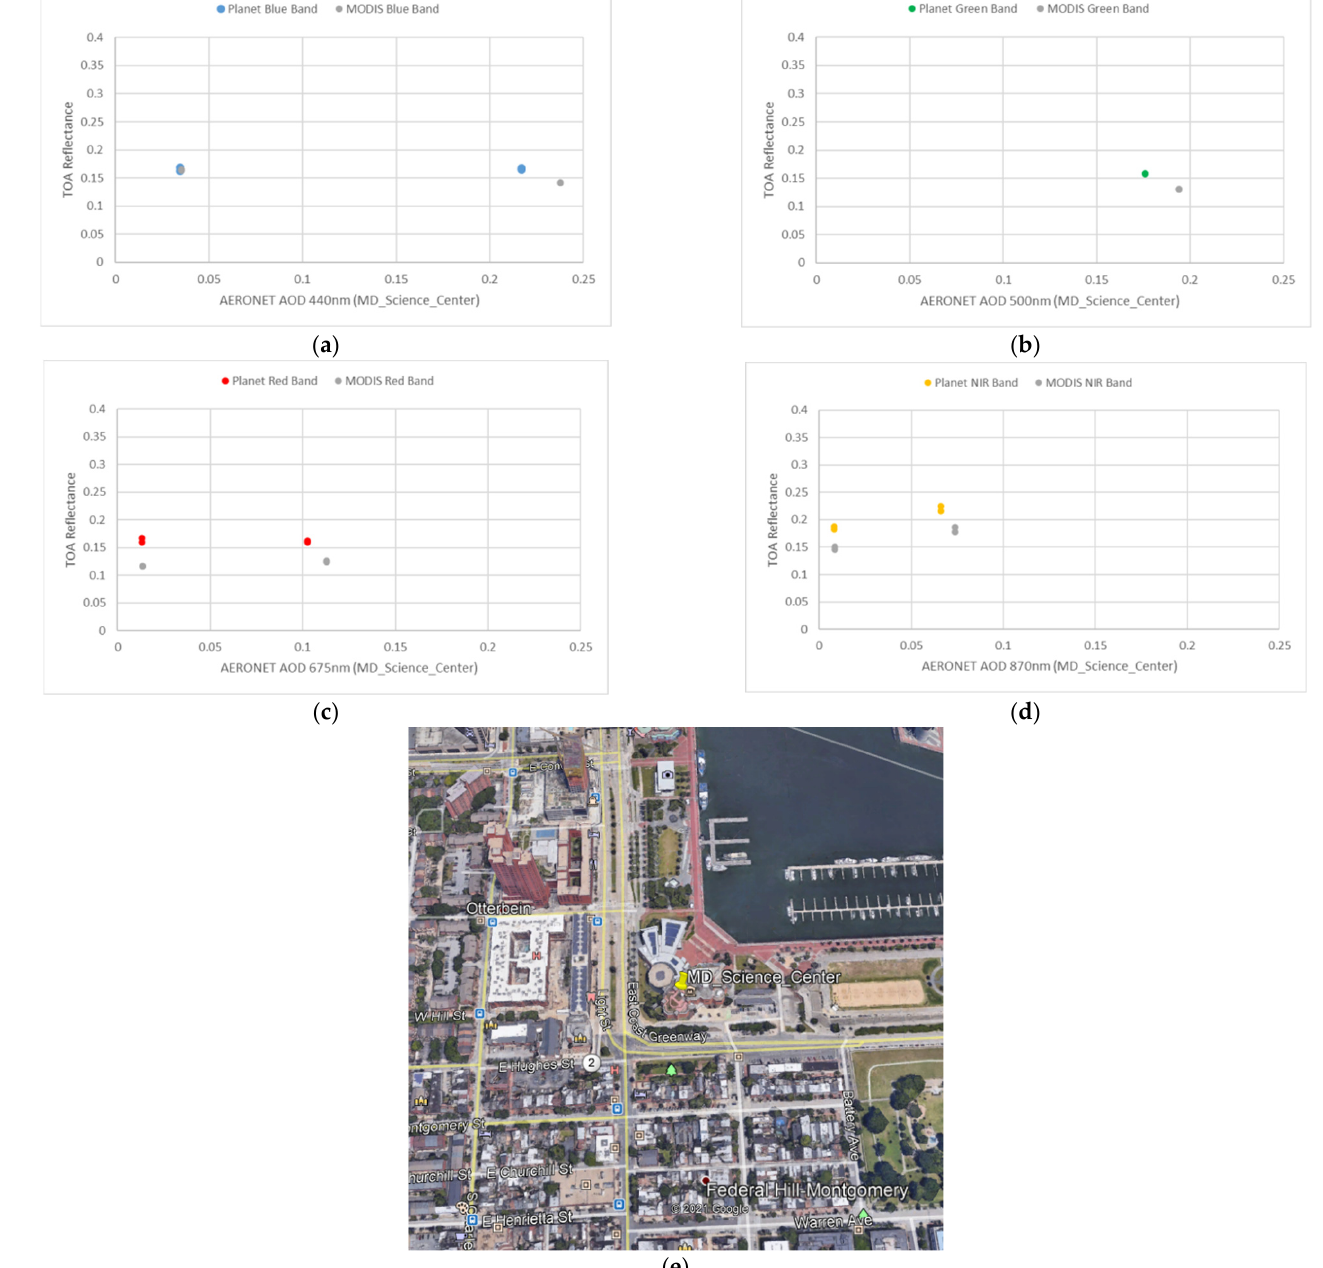
Figure A9. Data points from Figure 6 isolated for the MD_Science_Center AERONET site. Data points from the 5 × 5 and 10 × 10 pixel average plots are combined. Lower AOD values are from 3/22/2017 and higher AOD values are from 7/14/2018. Plots are separated by ( a ) blue band; ( b ) green band; ( c ) red band; ( d ) NIR band. No AERONET data was available for the 500 nm band on 3/22/2017 ( b ), so only values from 7/14/2018 are plotted for the green band. PlanetScope values are in color and MODIS values are in grey. The image in ( e ) shows a screenshot of the AERONET site location in Google Earth.